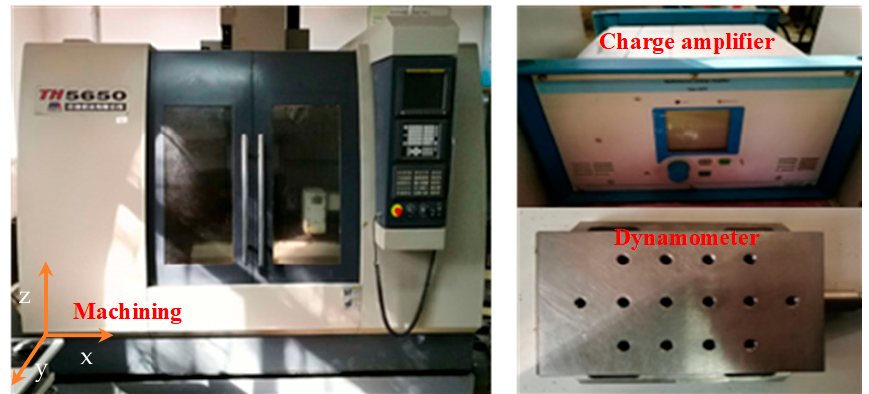
Figure 9. Experimental-related equipment. Table 2. The milling force coefficient experiment data tables.